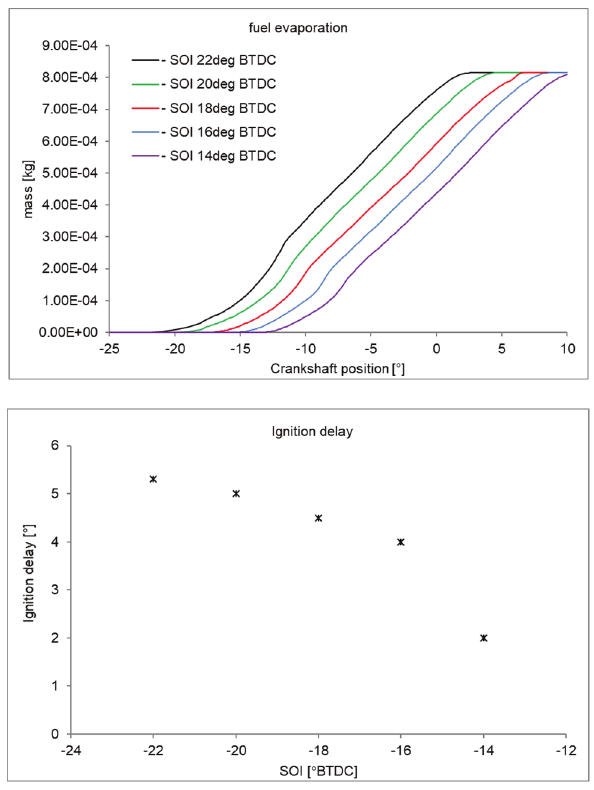
Fig. 1. Fuel mass evaporation and ignition